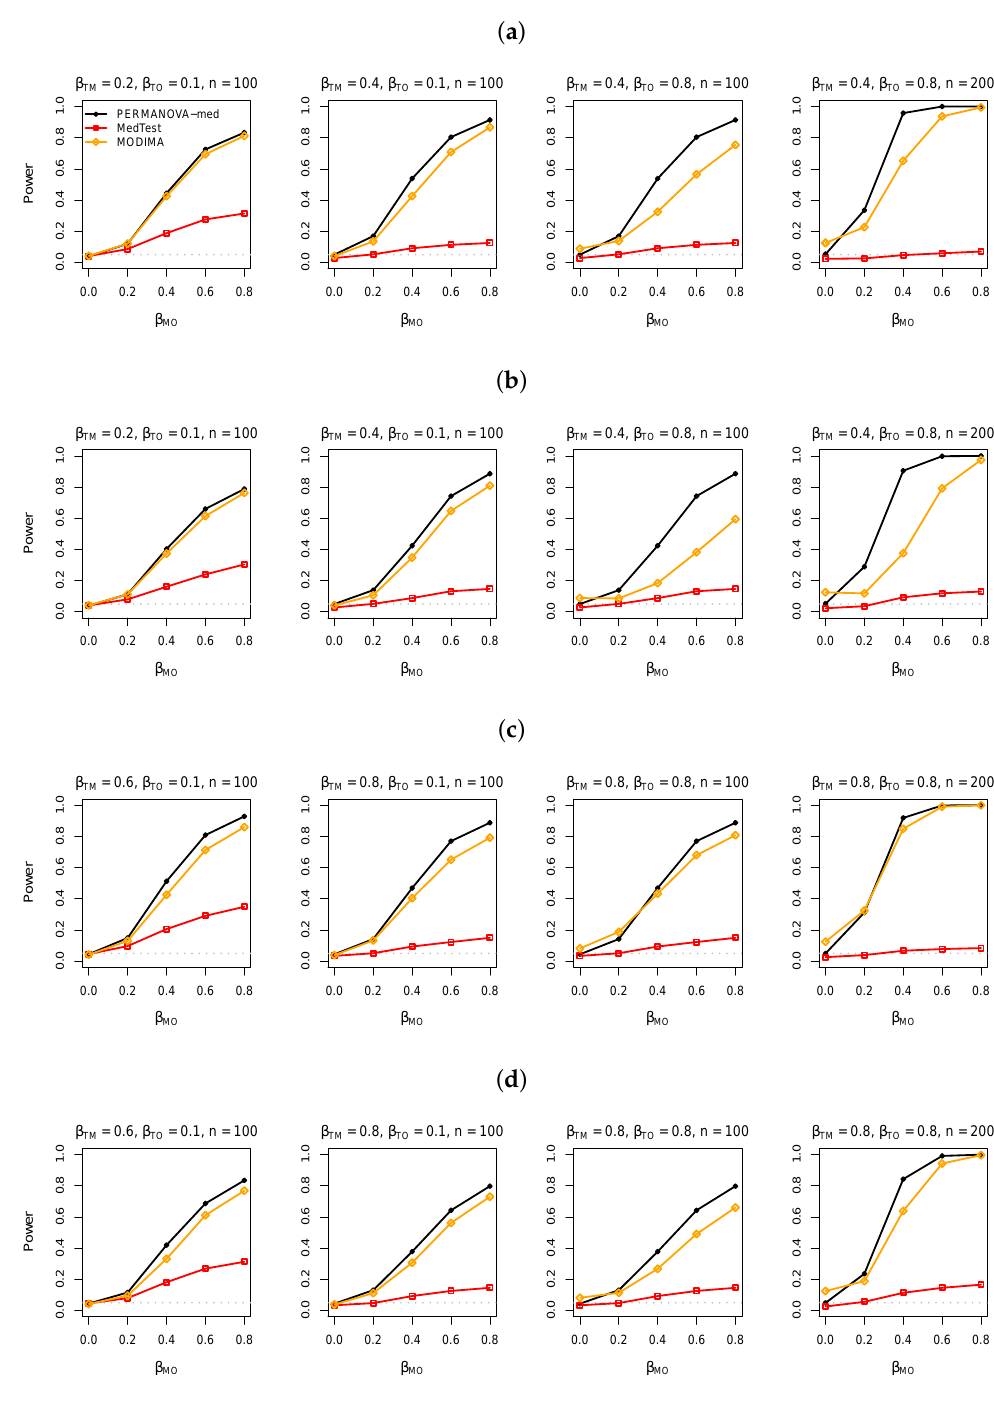
Figure 5. Simulation results in analysis of simulated data under M-rare. ( a ) Binary exposure, taxa 51–150 for the M-O association. ( b ) Binary exposure, taxa 101–150 for the M-O association. ( c ) Continuous exposure, taxa 51–150 for the M-O association. ( d ) Continuous exposure, taxa 101–150 for the M-O